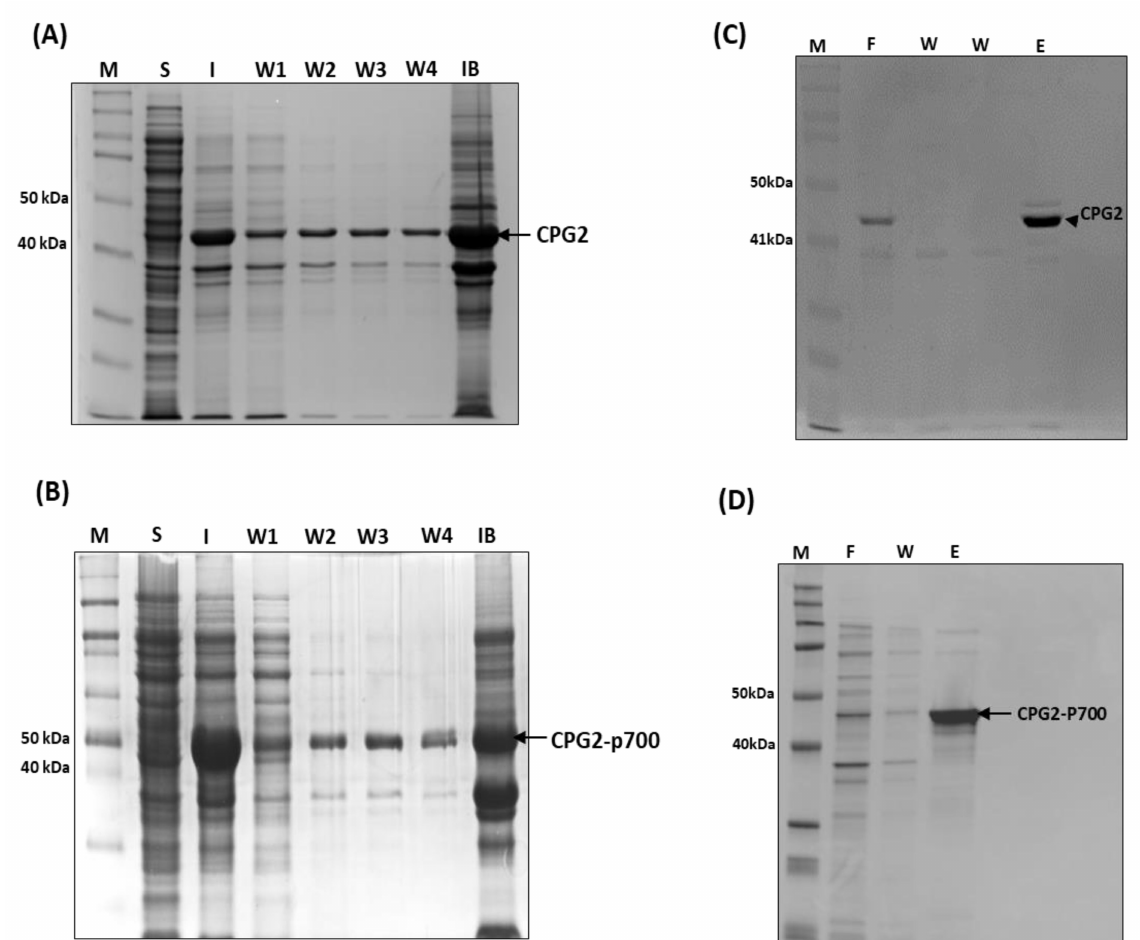
Figure 3. Purification of recombinant CPG2 proteins on nickel-chelate resin from urea washes derived from the insoluble fraction of BL21 E. coli cell lysates. ( A ) CPG2 and ( B ) CPG2-p700 coomassie blue stained SDS-PAGE gels. Lanes are of standard protein ladder; soluble fraction; insoluble fraction; four sequential urea washes; and remaining inclusion body, respectively, of IPTG-induced BL21 E. coli cells expressing. Pooled washes (1 to 4) from the insoluble fraction of lysates derived the IPTG-induced BL21 E. coli cells expressing His-tagged recombinant ( C ) CPG2 and ( D ) CPG2-p700 (right panel) were purified using a Ni2+ chelate column. Lanes (left to right) represent Coomassie Blue staining following SDS-PAGE of standard protein ladder, initial flow-through, wash and eluent (purified recombinant